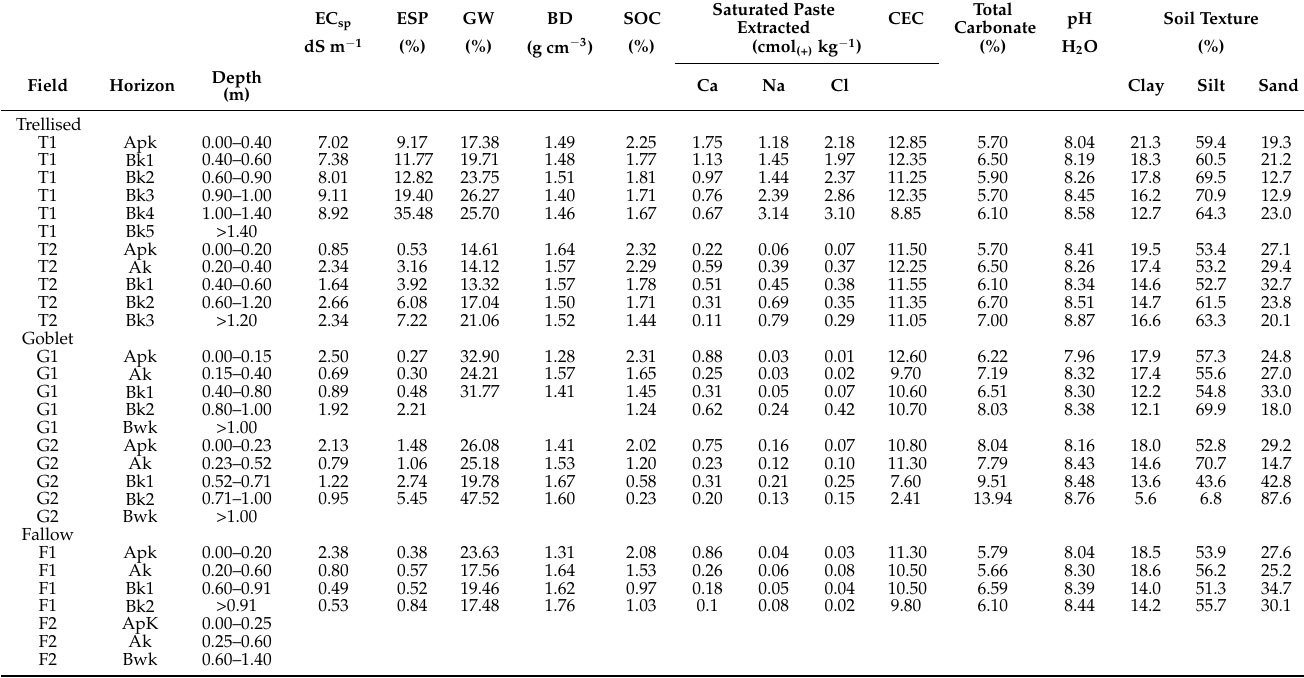
Table 1. Soil profile horizonation and associated physical and chemical properties. (A—horizon with accumulation of humified organic matter (humic horizon); B—subsurface horizons of illu- vial concentration of different soil components; p—signs of ploughing or other human distur- bance; k—accumulation of pedogenetic carbonates; w—development of colour or structure; GW— gravimetric